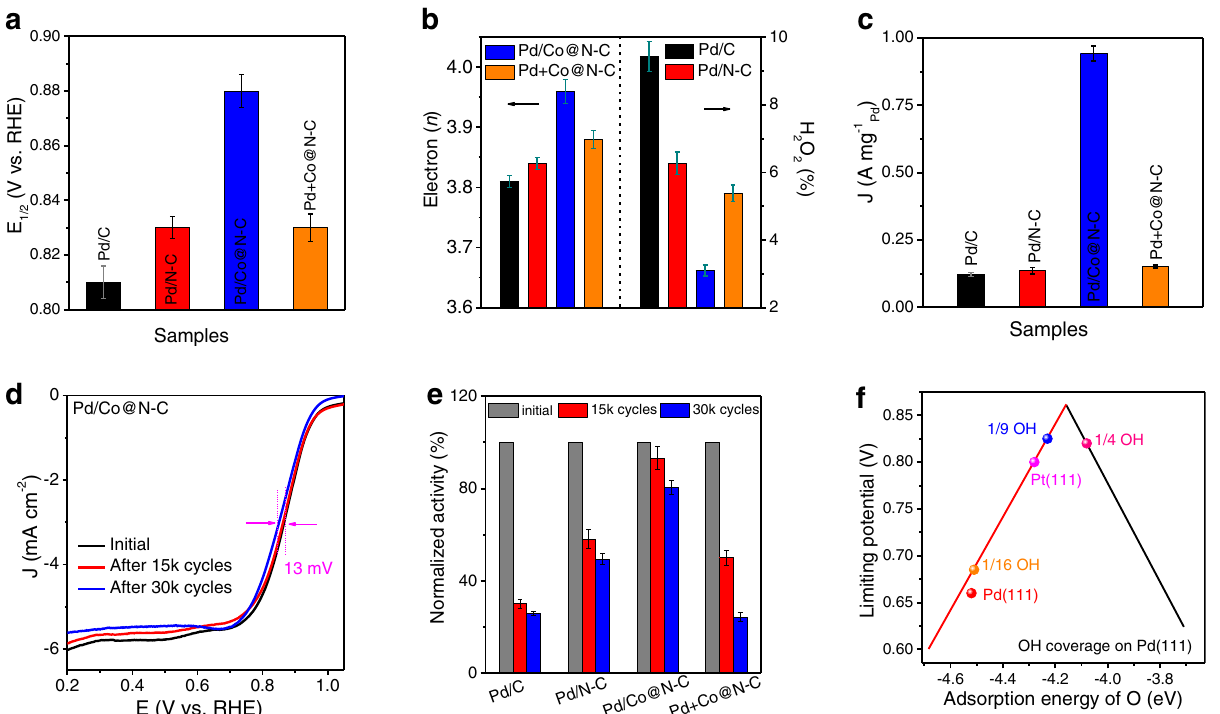
Fig. 5 | Synergistic interface effect of Pd/Co@N-C for electrocatalytic ORR performance.a ORRhalf-wavepotential(E 1/2 )ofdifferentsamples.RHE,reversible hydrogenelectrode.V,thevoltagewithoutcurrent(i)-resistance(R)compensation. b Electron transfer number ( n , left) and H 2 O 2 production (right) by RRDE test. c ORR mass activity at 0.9 V RHE . d ORR polarization curves of Pd/Co@N-C before